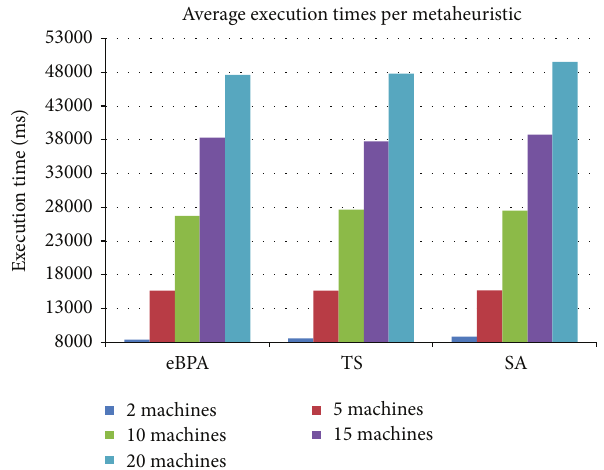
Figure 3: Average execution times per metaheuristic, per machine set, for the class of 500 jobs.